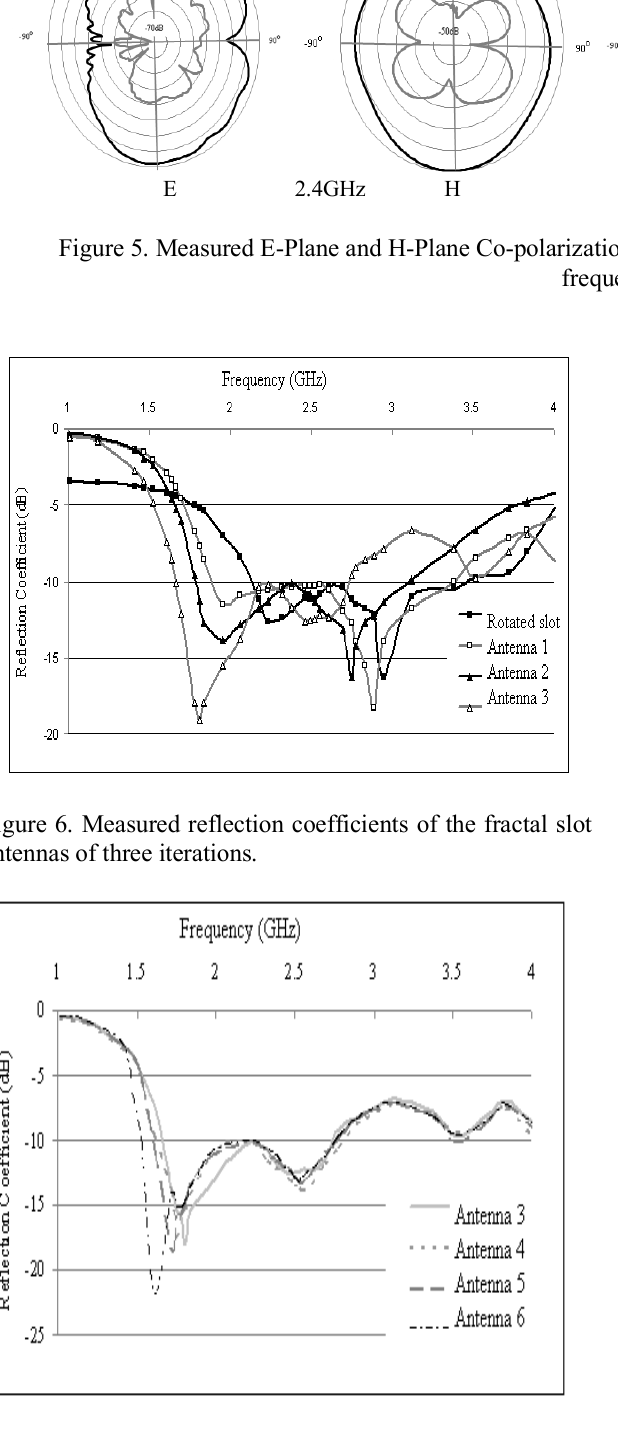
Figure 7. Measured reflection coefficients of the fractal slot antennas of iteration three with different IF and IA.